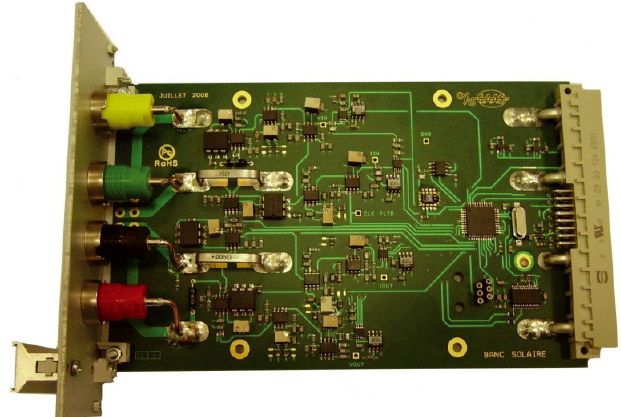
Fig. 9. Acquisition card of the photovoltaic automatic data acquisition system.